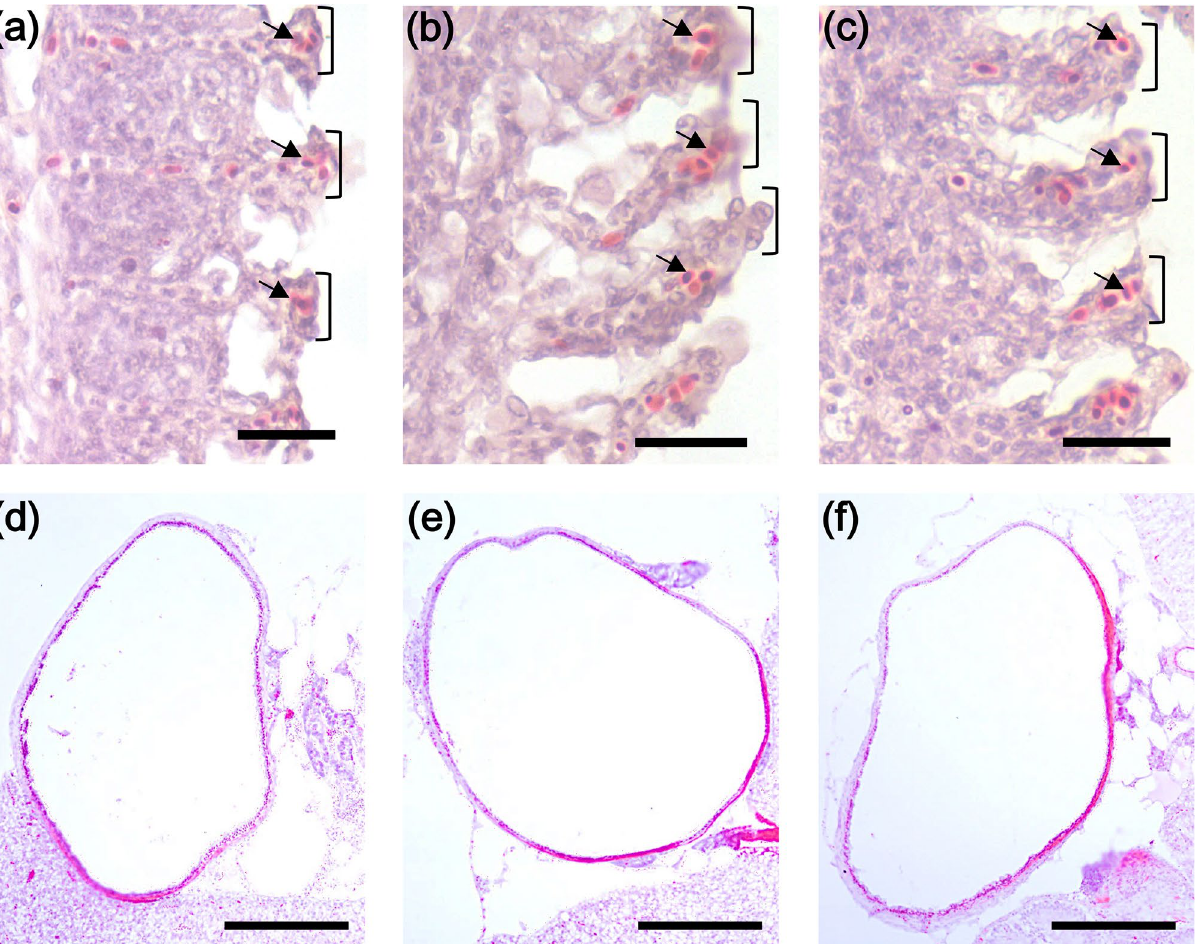
Figure 5. Histological evaluation of adult nt5e mutants. Transverse gill section of wild-type ( a ), nt5ea +/∆2 heterozygous ( b ), and nt5ea ∆2/∆2 homozygous ( c ) fish at 12 weeks post-hatching. Black parentheses and arrows show lamellae and erythrocytes, respectively. Transverse gallbladder section of wild-type ( d ), nt5eb +/∆10 heterozygous ( e ), and nt5eb ∆10/∆10 homozygous ( f ) fish at 12 weeks post-hatching. Scale bars indicate 25 µM ( a – c ) and 200 µM ( d – f ),